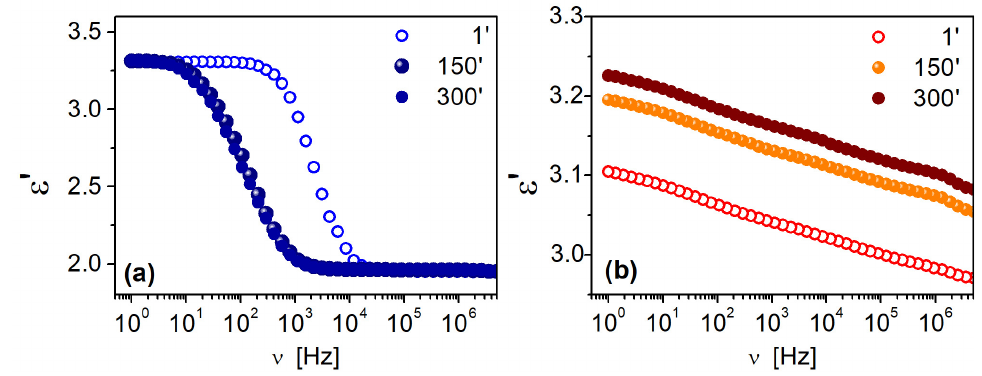
Figure 8. Frequency dependence of dielectric permittivity, measured for DDSQ-2Si(F1)-f sample ( a ) and DDSQ-2Si(F3)-f sample ( b ) in form of thin films. Presented data were collected after 1 min, 150 min and 300 min at T = 20 °C.